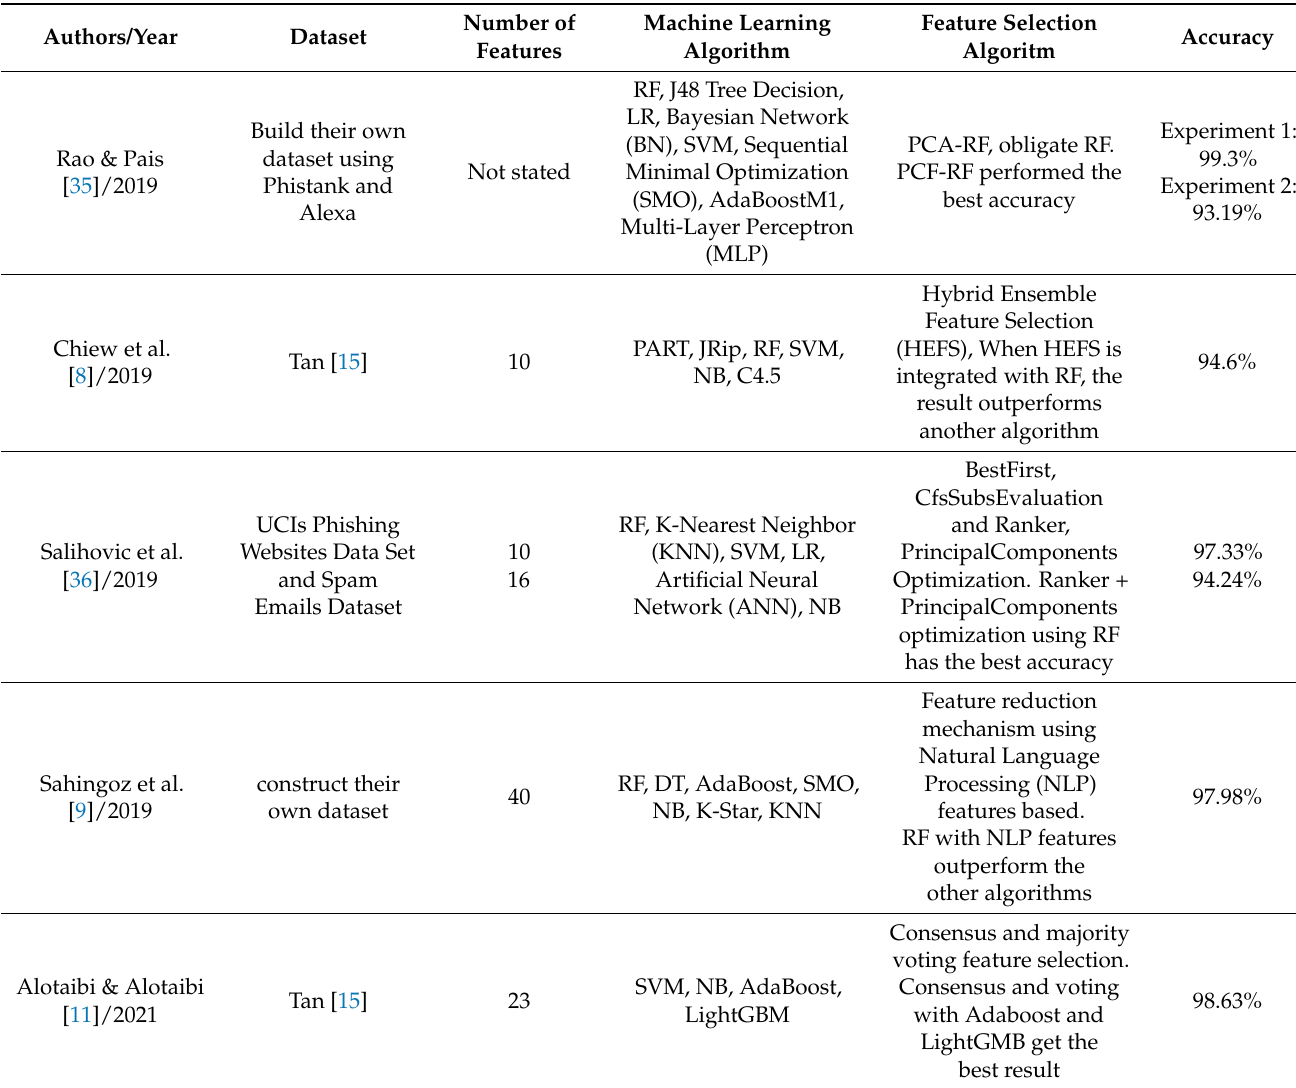
Table 2. Brief description of related